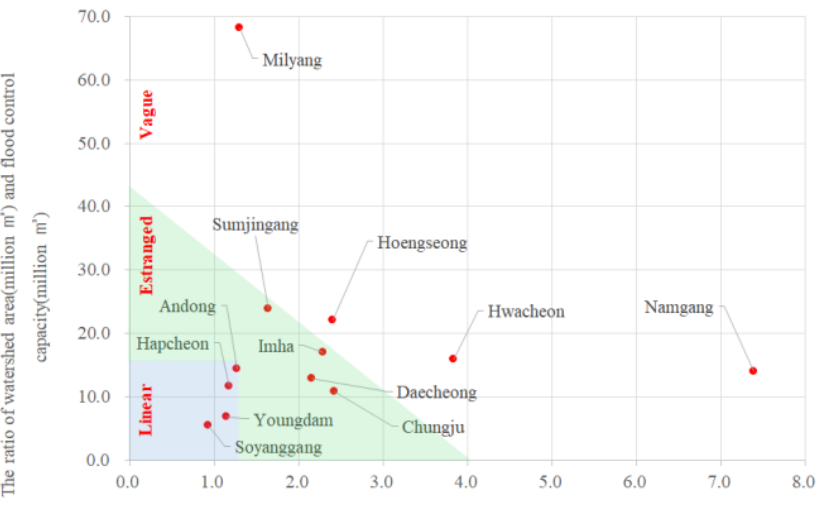
Figure 7. Scatter plot of the ratio of watershed area to storage capacity ( X -axis) and to flood control capacity ( Y -axis); blue area indicates Linear type, green area shows Estranged type, and other area means Vague type.